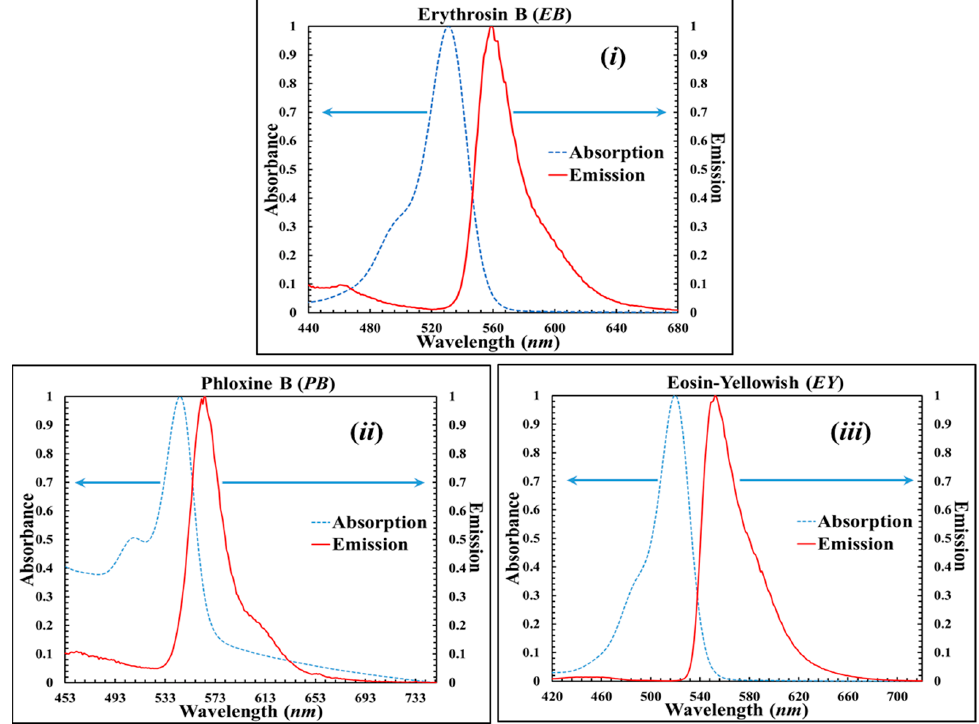
Figure 3. Normalized of absorbance (blue-dash curve) and emission (red curve) spectra plotted against wavelength for AA/PVA photopolymer material including different dyes: ( i ) EB; ( ii ) PB; and ( iii ) EY.